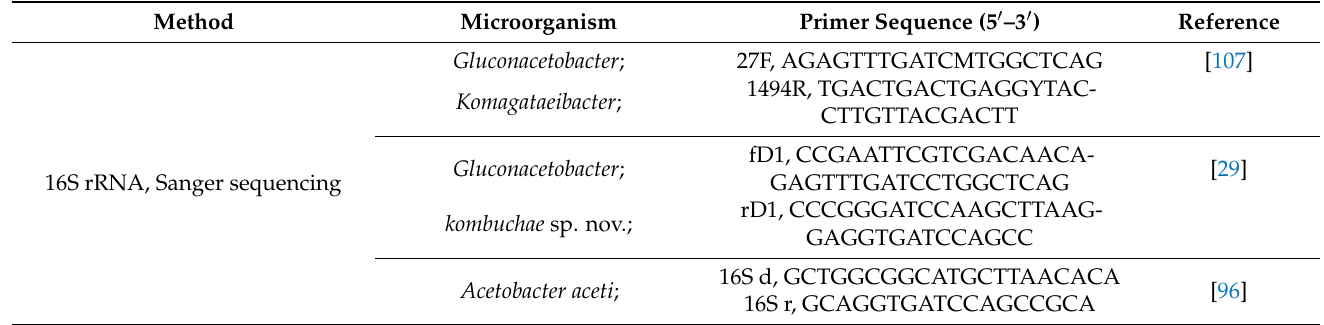
Table 10. Molecular techniques commonly used for AAB